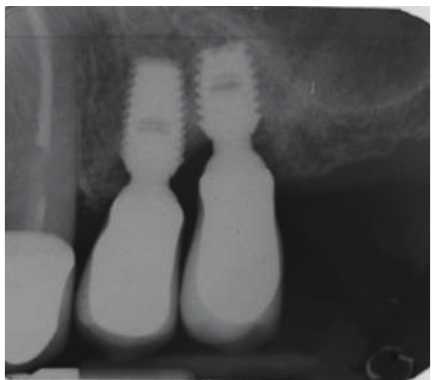
Figure 16: Two-year postoperative radiographs depicting radiopac- ity at the location of the defect, showing a near complete regenera- tion of the missing